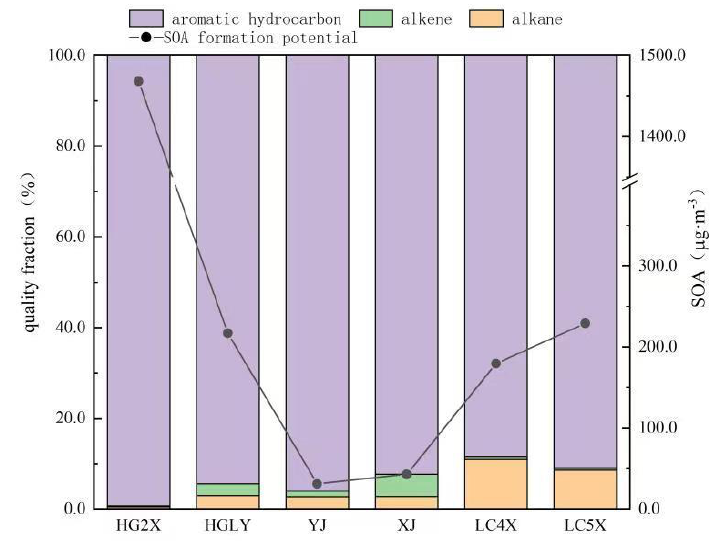
Figure 3. SOA values of VOCs from six circulating cooling water systems.